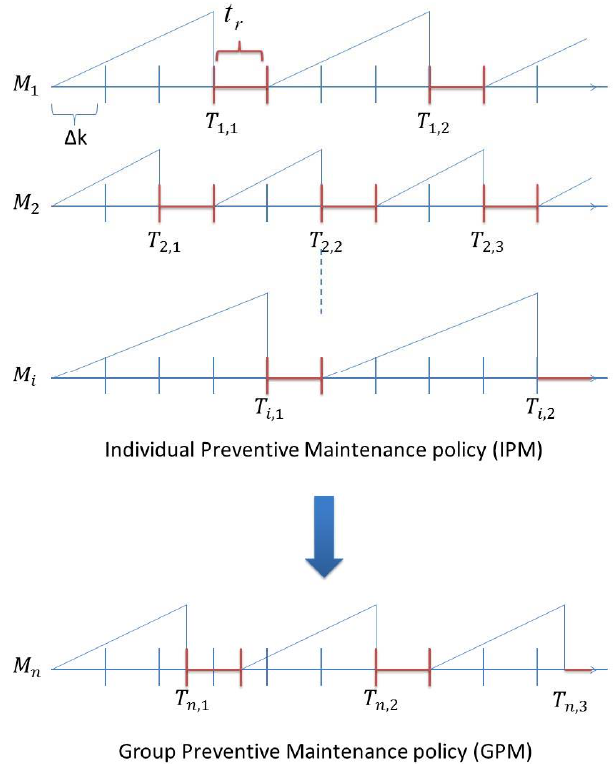
Figure 2. Comparison between IPM and GPM policies.